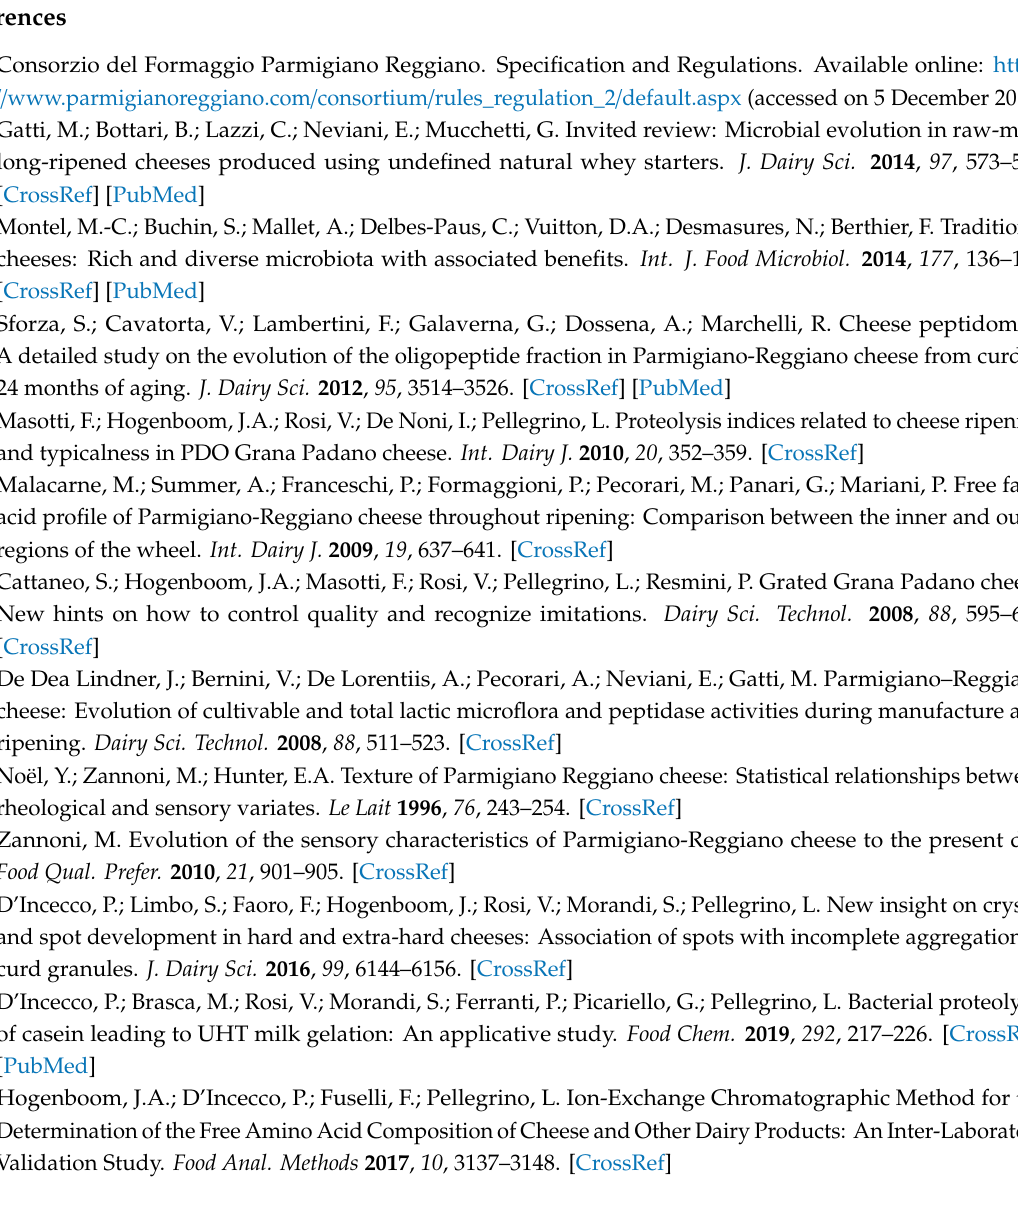
Figure S1: Parmigiano Reggiano manufacture process; Table S1: Free amino acid composition of Parmigiano Reggiano cheeses ripened up to 50 months; Table S2: Number of tyrosine crystals and spots counted in Parmigiano Reggiano cheeses ripened up to 50 months; Table S3: Correlation coe ffi cient